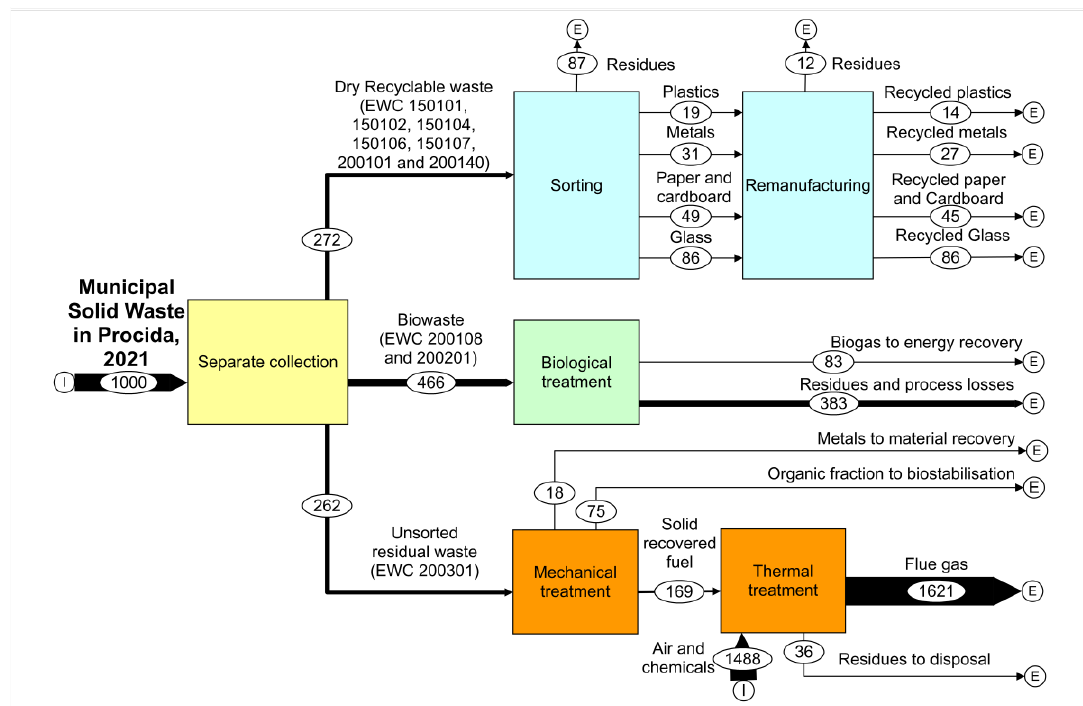
Figure 2. Quantified flow sheet of MSW management in Procida in 2011 ( top ) and 2021 ( bottom ), with reference to functional unit. Data are expressed in kg. EWC: European waste code; I: import; E: export. Data Source: W-MySir [7].